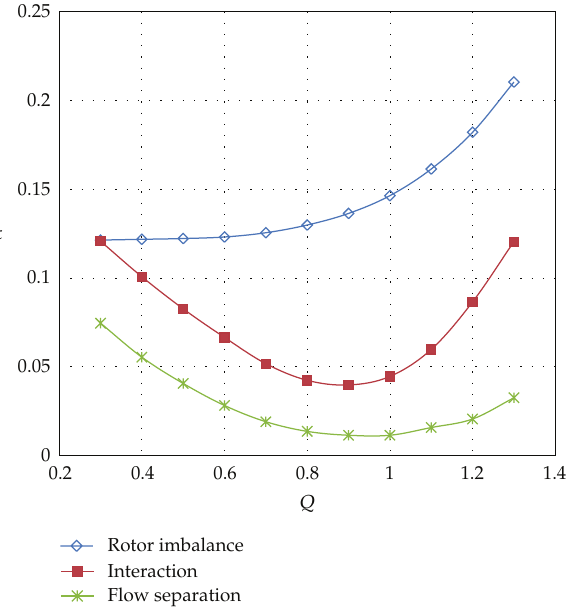
Figure 1: Forces in the